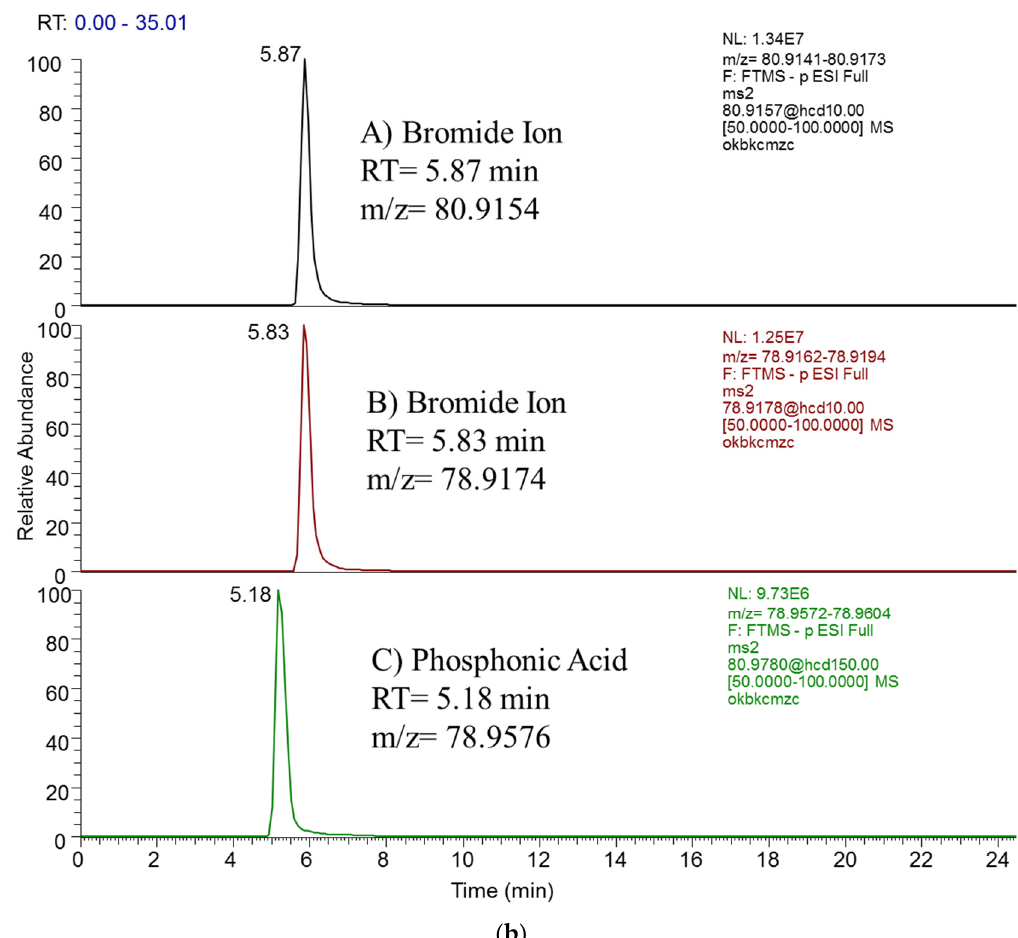
Figure 2. Identification of bromide ion and phosphonic acid: ( a ) PRM acquisition in ESI-: bromide ion quantifier, m/z = 80.9154; bromide ion qualifier, m/z = 78.9174; and phosphonic acid, m/z = 78.9576; ( b ) chromatogram of the bromide ion at RT = 5.87 min (quantifier and qualifier) and phosphonic acid at RT = 5.18 min.